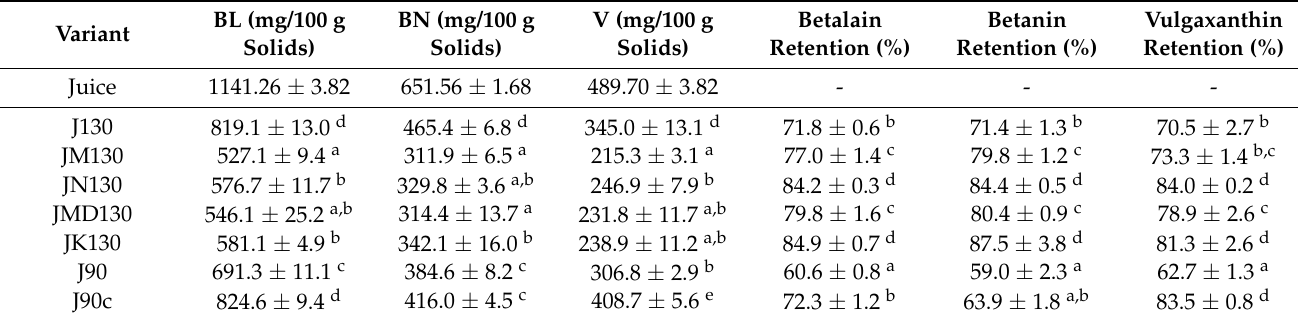
Table 5. Betalain (BL), betanin (BN), and vulgaxanthin (V) content and the retention of betalains in the obtained cloudy beetroot juice powders (abbreviations of variants explained in Table